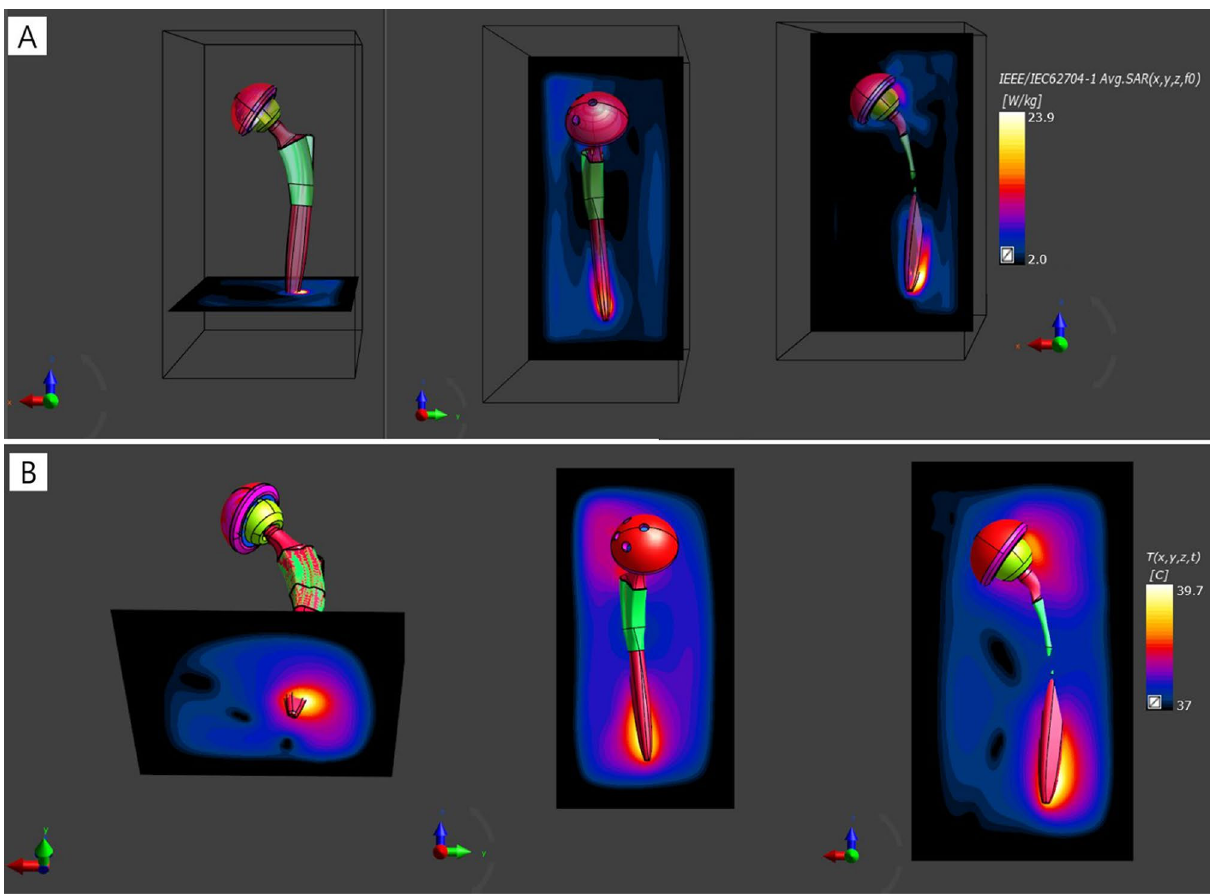
Figure 1. SAR ( A ) and Temperature distribution ( B ) near an artificial hip joint using Sim4Life version 4.4 software (Zurich Med Tech, Zurich, Switzerland. https ://zmt.swiss /sim4l ife/). The local SAR values were normalized to the whole-body averaged SAR of 2 W/kg. The SAR value was 23.9 W/kg near the tail of the artificial hip joint. The maximum temperature (= 39.7 °C at 8 min exposure at MRI, compared to base temperature at 37 °C) appear near the tail of the artificial hip